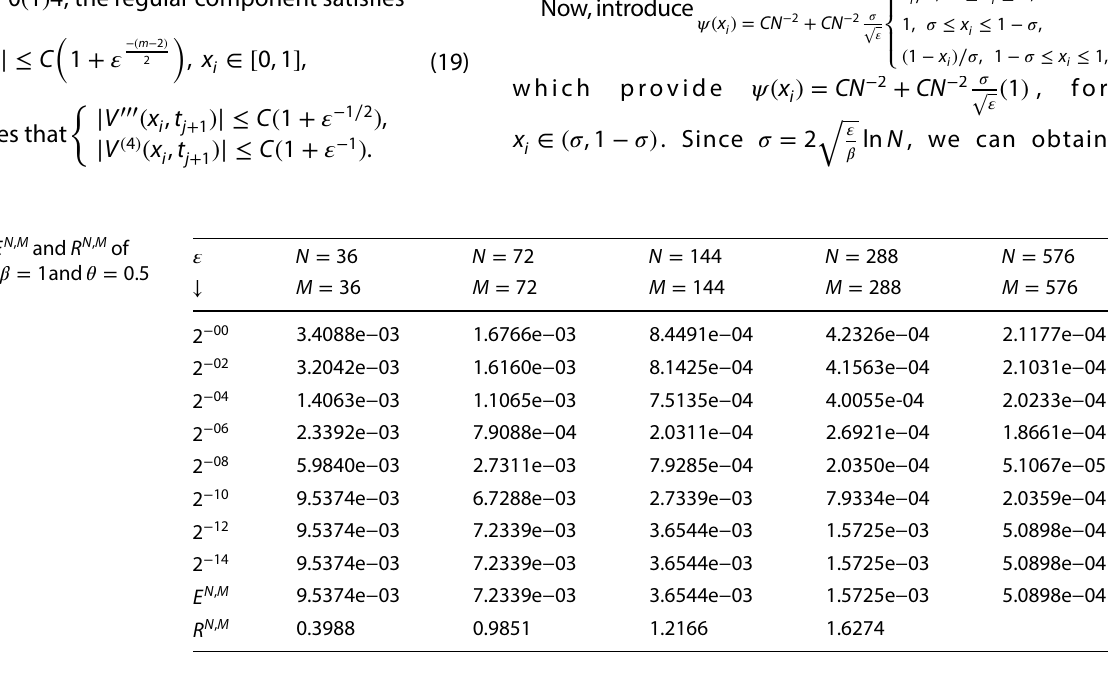
Table 2 E N , M 𝜀 , E N , M and R N , M for Example 2, taking 𝛽 = 1.5 and 𝜃 = 0.5